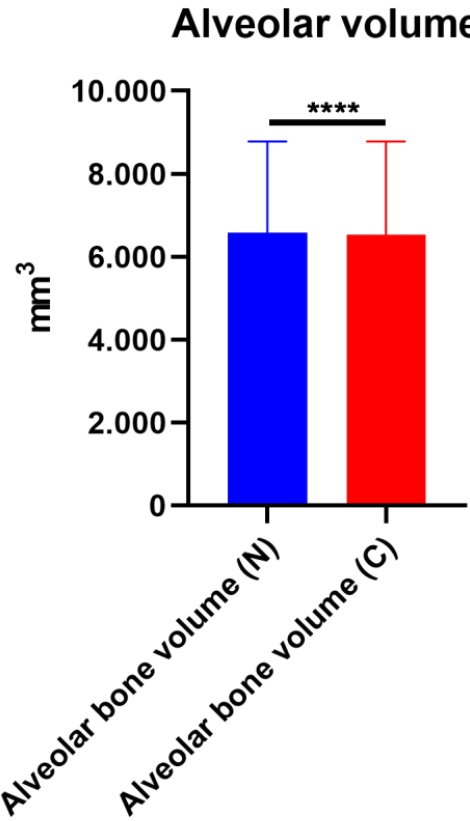
Figure 4. Difference in alveolar bone volume between cleft and normal sides. **** p < 0.0001. We performed a correlation test for the bony gaps on CT scans and discrepancies in lip and nose anthropometric measurements between the normal and cleft sides (Table 3). C1 was positively correlated with lip height (F2; correlation coefficient (r) = 0.564, p = 0.0051) and dry vermilion thickness (F3; r = − 0.543, p = 0.0074). In the linear regression test, there were significant correlations between C1 and F2 (r 2 = 0.318, p = 0.0051, Figure 5) and between C1 and F3 (r 2 = 0.295, p = 0.0074; Figure 5). However, there was no correlation between alveolar height and nasal anthropometric measurements. Table 3. Correlation test between bone and soft tissue.